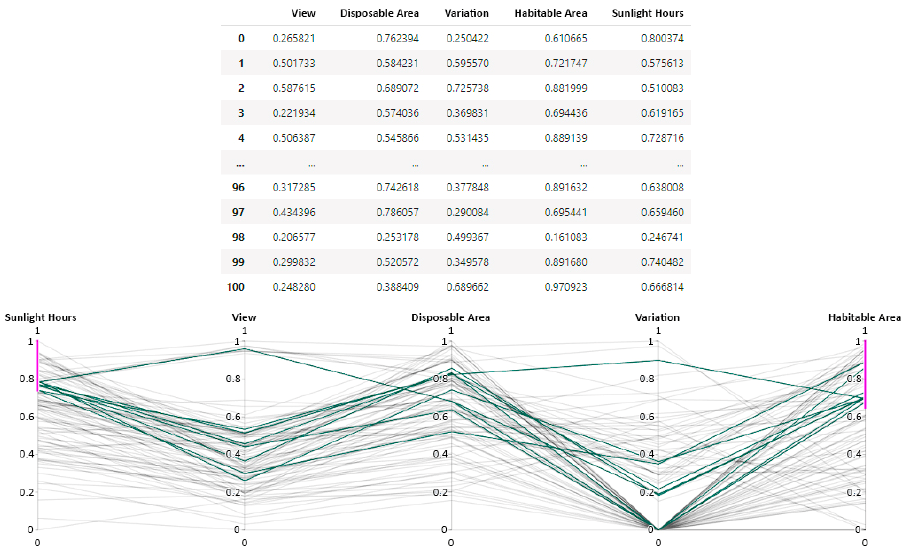
Figure 7. Example of a solution set and its metrics, showing a table of solution metrics and a parallel coordinate chart of solution metrics.